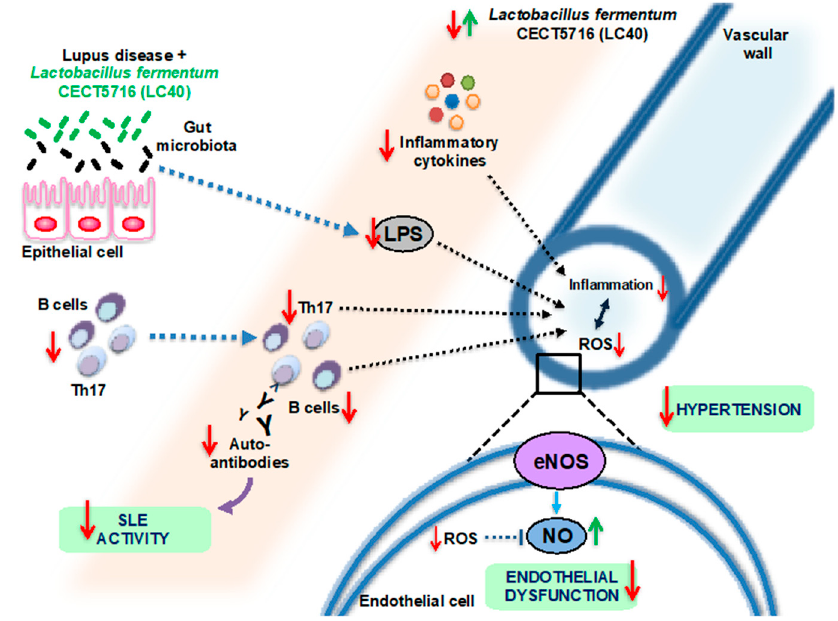
Figure 3. Proposed mechanism by which Lactobacillus fermentum CECT5716 (LC40) administration could prevent SLE activity, endothelial dysfunction and hypertension in the NZB / WF1 model (based on data from publication no.